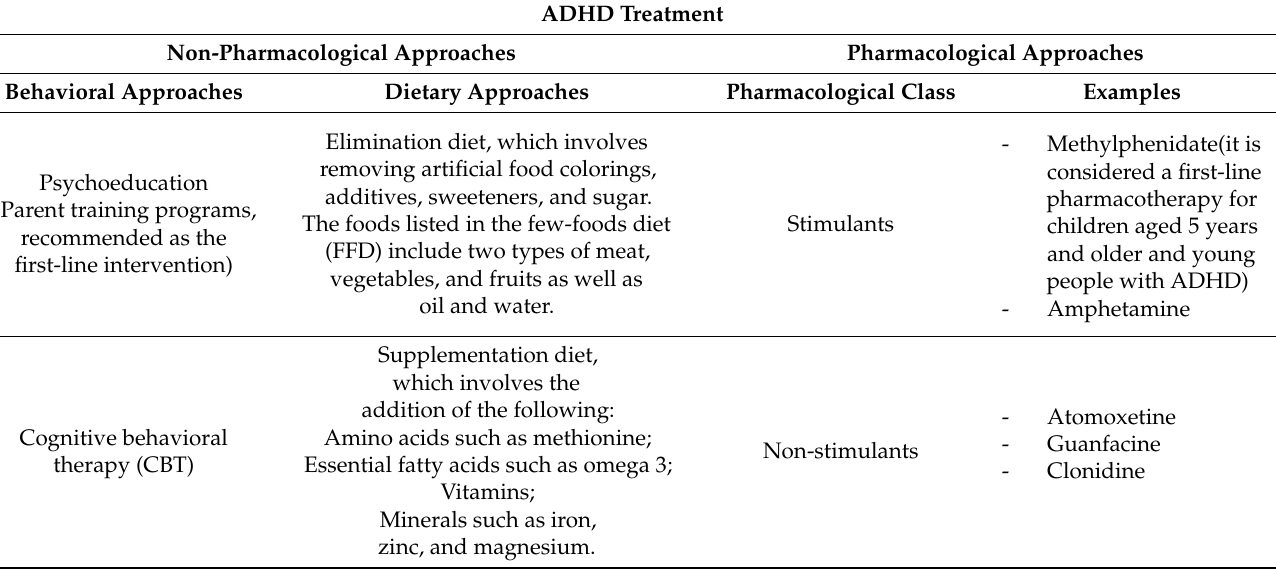
Table 1. Overview of the treatment approaches for